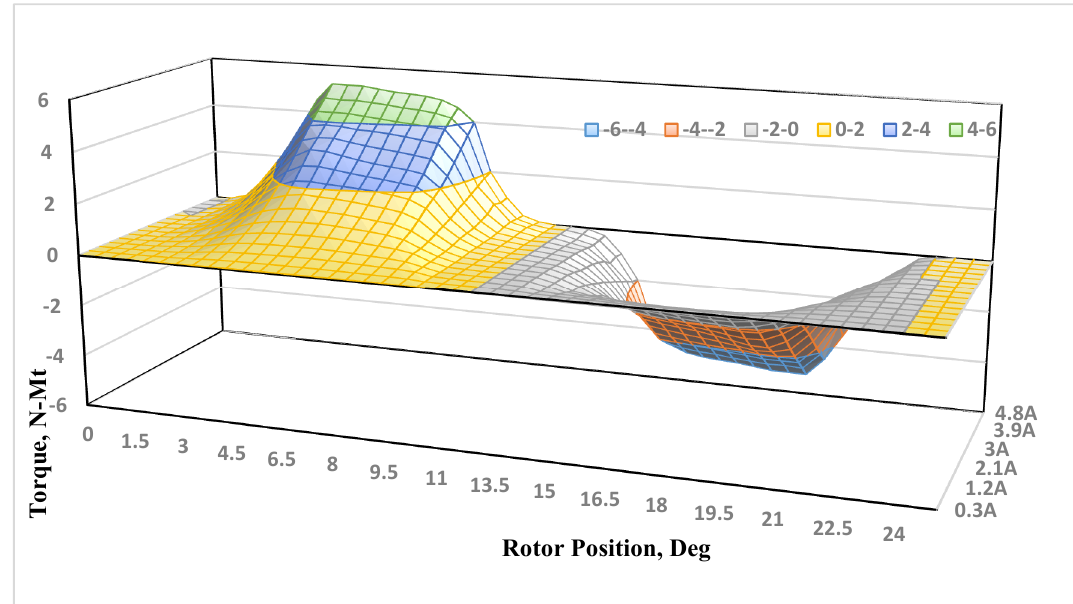
Figure 6. Nonlinear torque profile of torque winding.